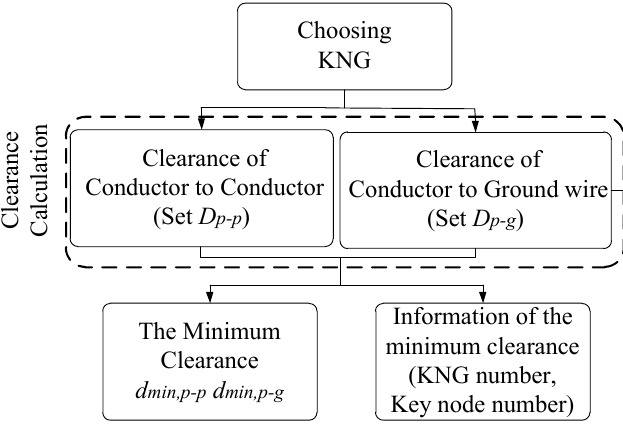
Figure 7. The flow chart of KNM.